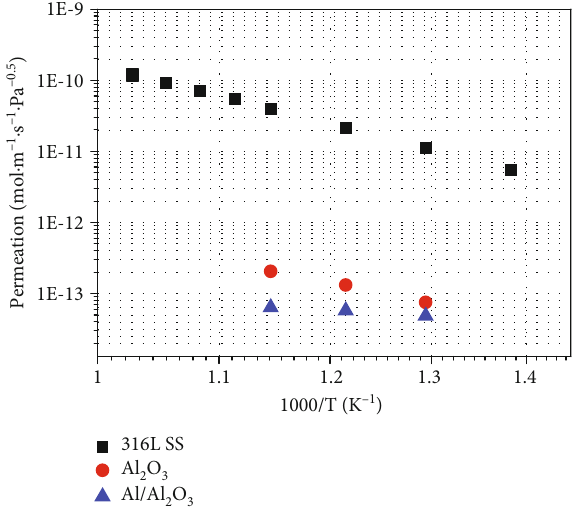
Figure 6: Deuterium permeability through the Al/Al and bare 316L stress steel as a function of the permeation temperature. The test deuterium permeation pressure is